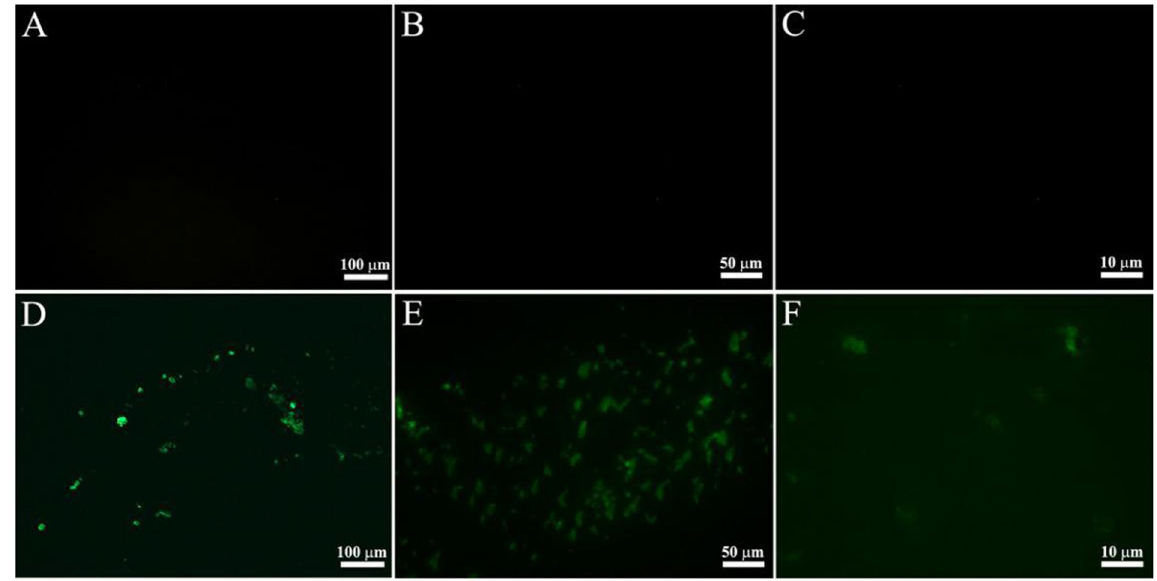
Figure 3. Fluorescence images of the PEG-CSAuNAs ( A – C ) before and ( D – F ) after the labeling of FITC. The images were obtained at different magnifications of ( A , D ) 200 × , ( B , E ) 400 × and ( C , F ) 1000 × . Excitation light was 488